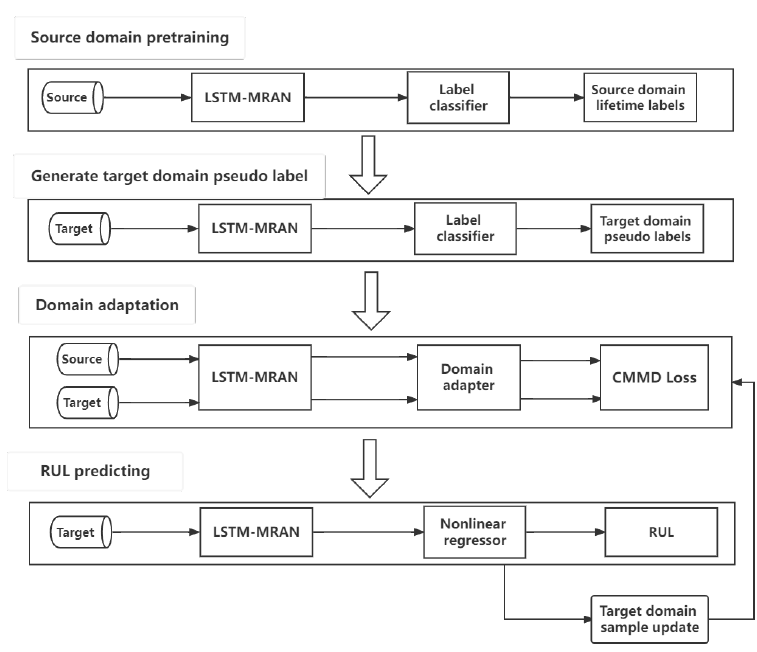
Figure 2. Structure of LSTM-MRAN.